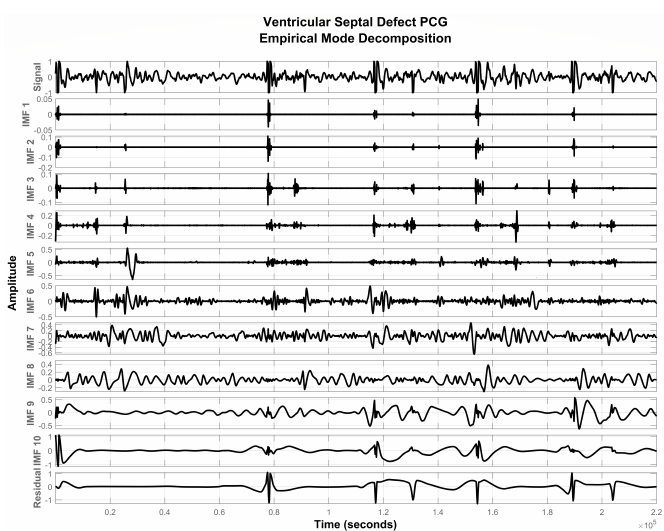
Figure 4. IMFs extracted from the PCG signal of an ASD subject.